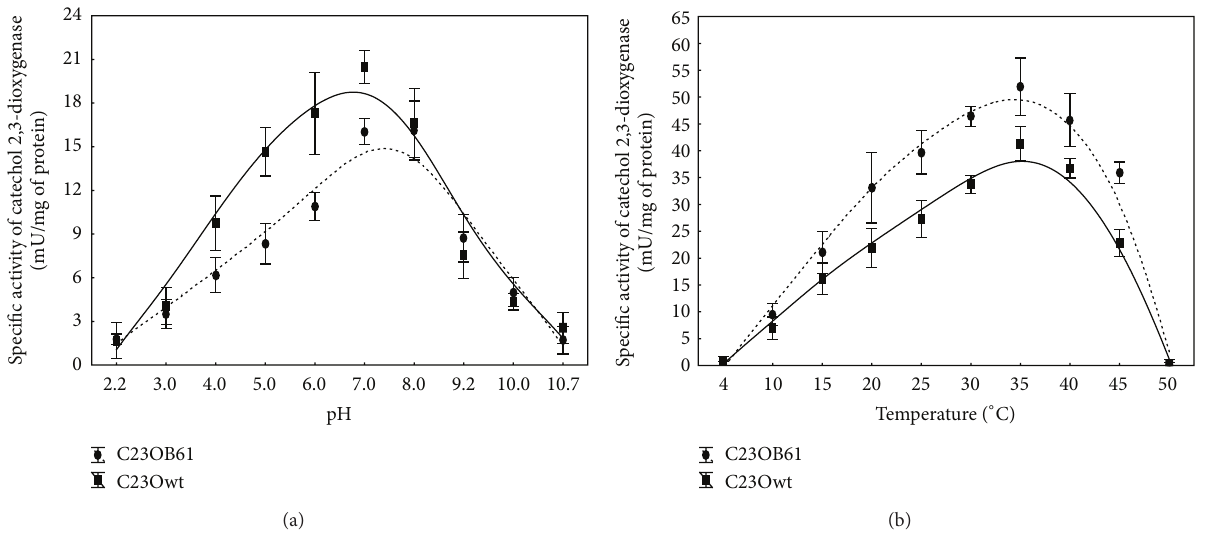
Figure 2: Effects of pH (a) and temperature (b) on the activity of wild-type (C23Owt) and the mutant (C23OB61) dioxygenases. The data shown in this figure represent the mean ± SD of four experimental